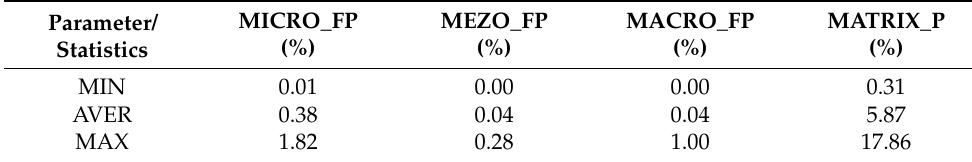
Table 4. Simple statistics (MIN—minimum, AVER—average, MAX—maximum) of the porosity from logs and laboratory data integration. G-10 borehole.